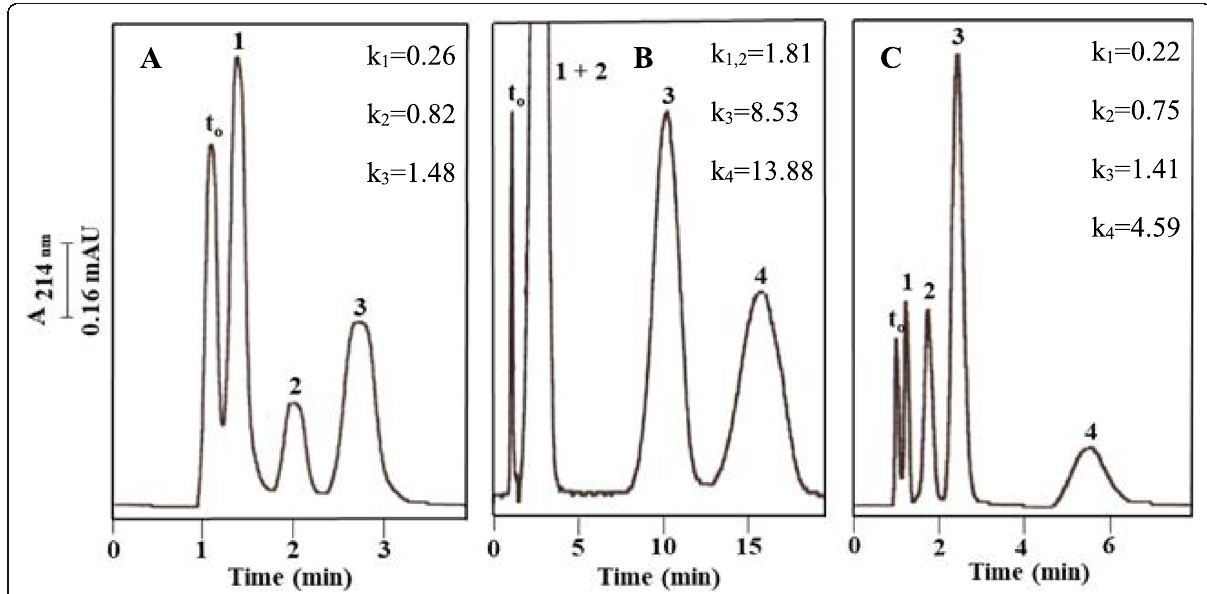
Fig. 2 Chromatograms of small neutral polar solutes ( a ), nucleobases ( b ), and organic acids ( c ) obtained on FSNPs-poly(GMM-co-EDMA) monolithic column. Separation conditions: column, 10 cm × 4.6 mm i.d with 0.6 mg of FSNPs/cm; flow rate, 1 mL/min; injection volume, 20 μ L; column temperature, room temperature. For a , mobile phase, 95% ACN (v/v), 5% water (v/v); solutes: 1, DMF; 2, formamide; 3, thiourea; t 0 , toluene. For b , mobile phase, 95% ACN (v/v), 5% of 10 mM ammonium acetate, pH 4.0 (v/v); solutes: 1, thymine; 2, uracil; 3, adenine; 4, cytosine; t 0 , toluene. For c , mobile phase, 95% ACN (v/v), 5% of 10 mM ammonium acetate, pH 4.0 (v/v); solutes: 1, m -toluic acid; 2, salicylic acid; 3, sulfanilic acid; 4, sulfosalicylic acid; t 0 ,